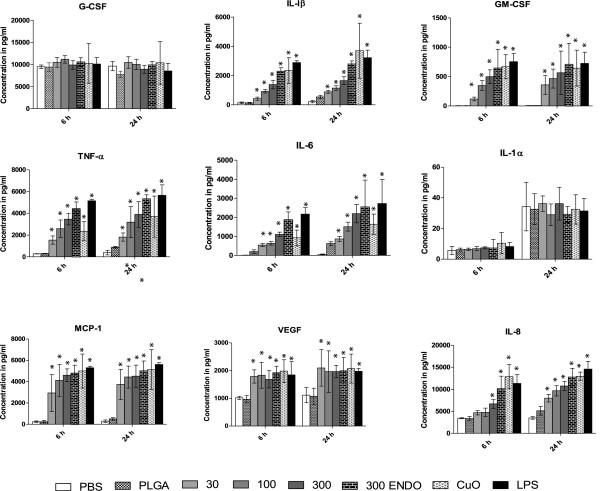
Levels of various cytokines at 6 and 24 h after nanoparticle treatment in THP-1 cell line. The concentrations of various cytokines measured in cell culture supernatant after nanoparticle treatment at different time points. All values are in picograms and are represented as mean± SE.